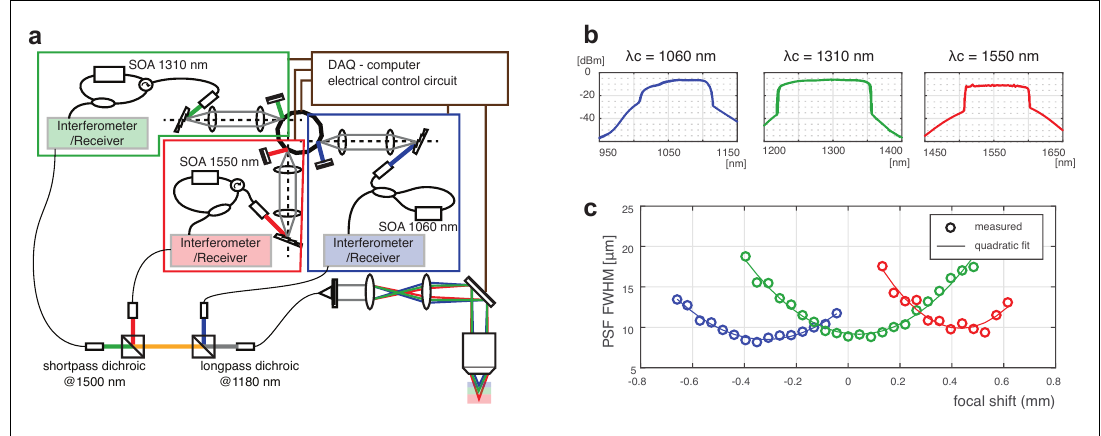
Figure 1. Triband system overview. ( a ) System schematic. Each band has its own interferometer and polarization-diverse receiver (not shown). ( b ) Optical spectrum of each swept source and ( c ) Measured transverse PSF as a function of depth for each band (blue: 1060 nm; green: 1310 nm; red: 1550 nm). Each spectral band had a dedicated interferometer with acousto-optic frequency shifter [24] and optical circuit for polarization-diverse detection (not shown in Figure 1) [25]. Polarization-sensitive detection avoids signal fading and slightly improves image quality by reducing speckle